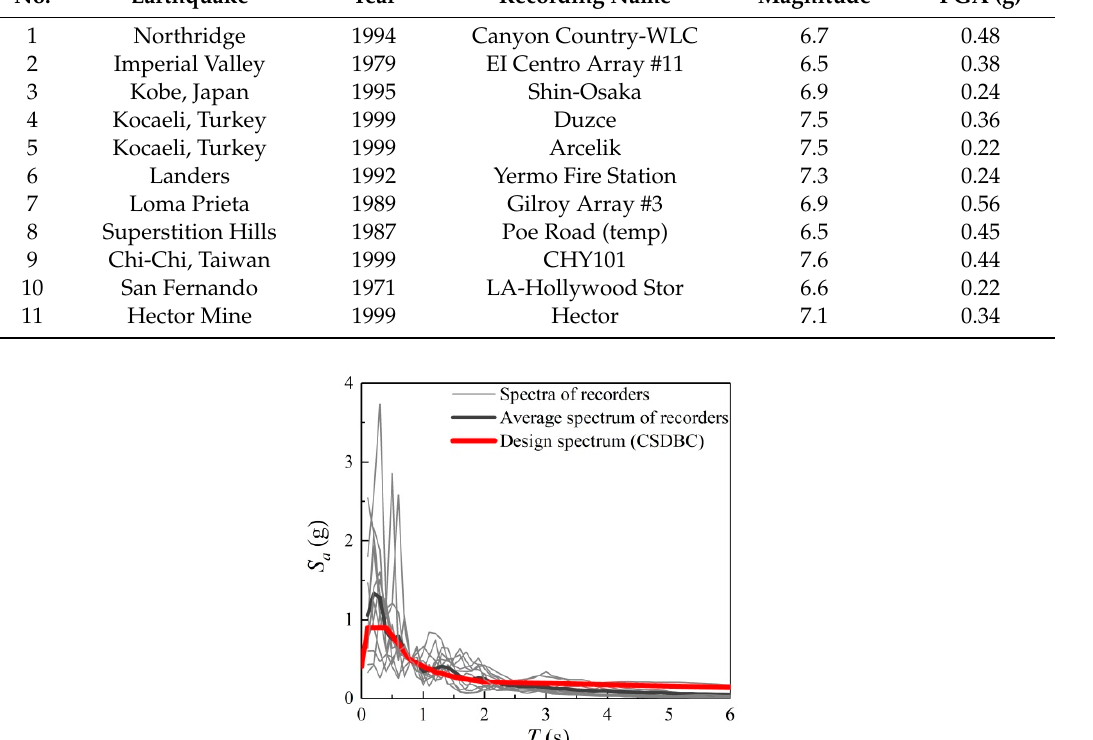
Figure 4. Elastic response spectra of selected earthquake set and CSDBC design spectrum for soil type II (5% damping). Table 2. Basic information of selected ground motions .